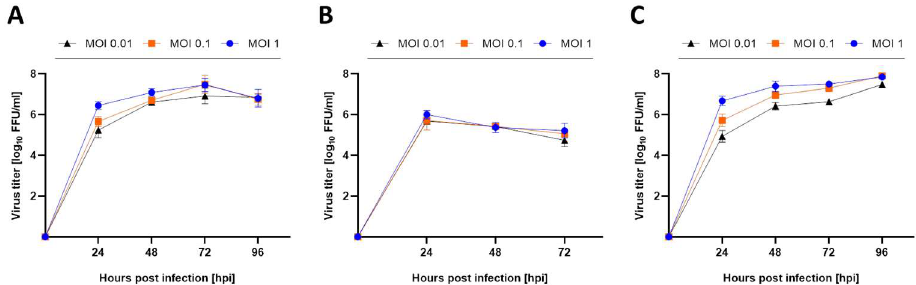
Figure 1. USUV replication kinetics varies in different cell lines. ( A ) Vero CCL-81, ( B ) A549 and ( C ) TME-R cell lines were infected with varying MOI doses (MOI of 0.01; MOI of 0.1; MOI of 1.0) of USUV lineage Africa 3 for 2 h. Parts from the supernatants were harvested every 24 h and viral infectivity was determined by focus-forming assay in Vero CCL-81. All experiments were performed in independent triplicates. Viral titer is depicted as mean log 10 FFU/mL ± SD.